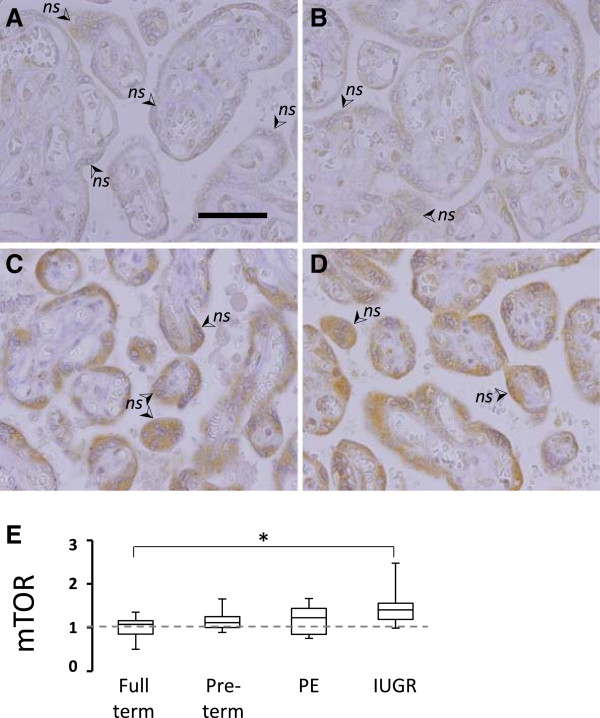
mTOR protein expression in placenta ST. Placenta of A, full-term control, B, pre-term control, C, preeclampsia, and D, intrauterine growth restriction-associated pregnancies were probed with antibodies recognizing total mTOR protein. (➢ Arrow denotes ns, nuclei syncytia. Size bar in A = 100 mM). E, Estimated mTOR IHC scoring data is presented in box and whiskar format to define minimum and maximun values (capped bars), 2nd and 3rd quartile (box) and median (line through box). Data was normalized to full term controls (mean set to 1, grey dashed line) (n = 10 each, * p < 0.05).